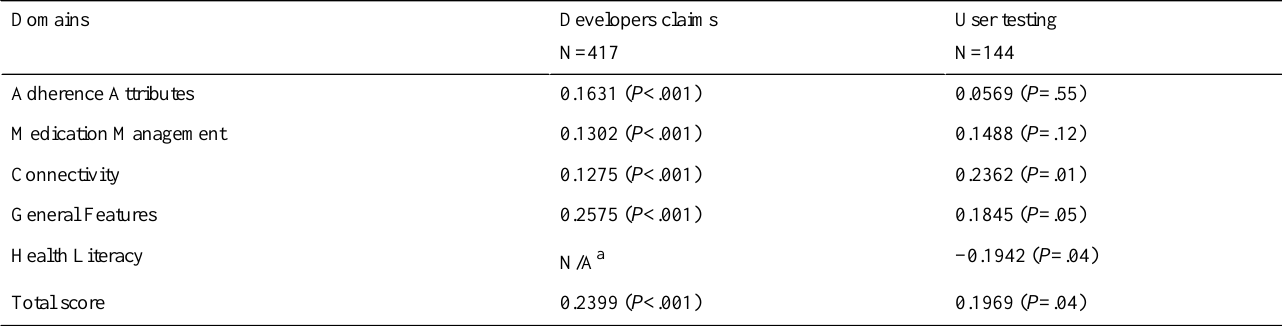
Table 4. Pearson correlation coefficients between consumer ratings and adherence app evaluations based on developers claims and user